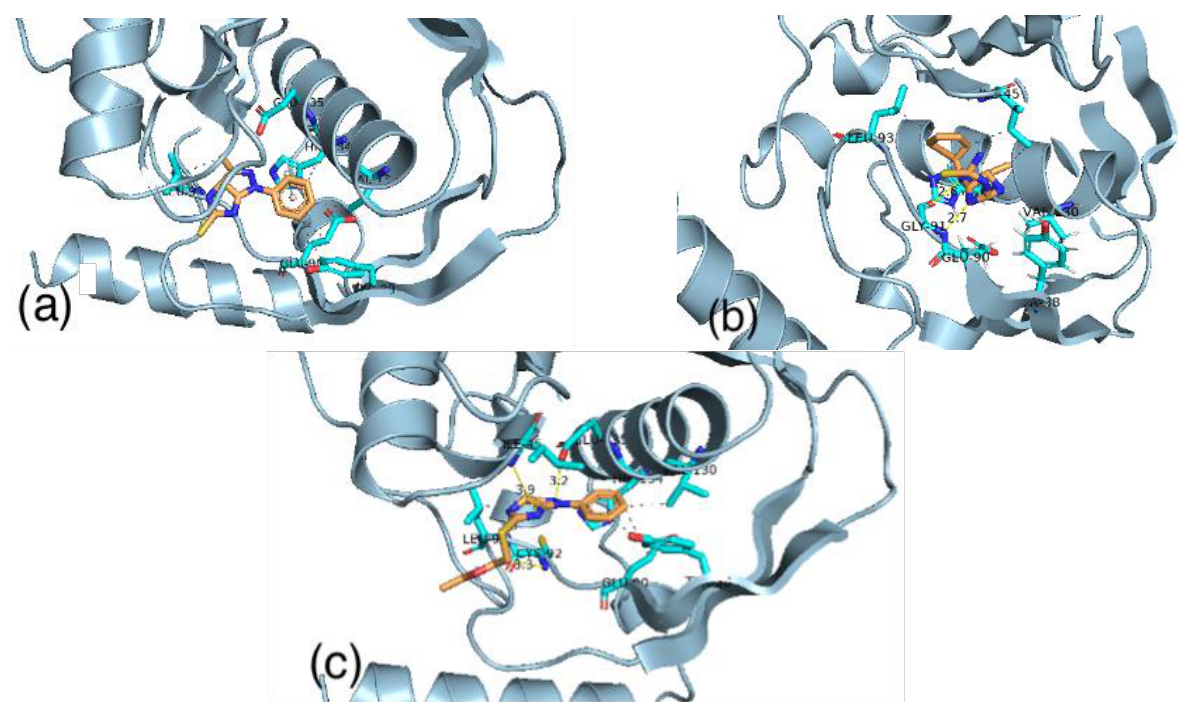
Figure 6. The binding of ligand (1) ( a ) ligand (2) ( b ) and ligand (3) ( c ) with the active site of Pseudomonas aeruginosa.